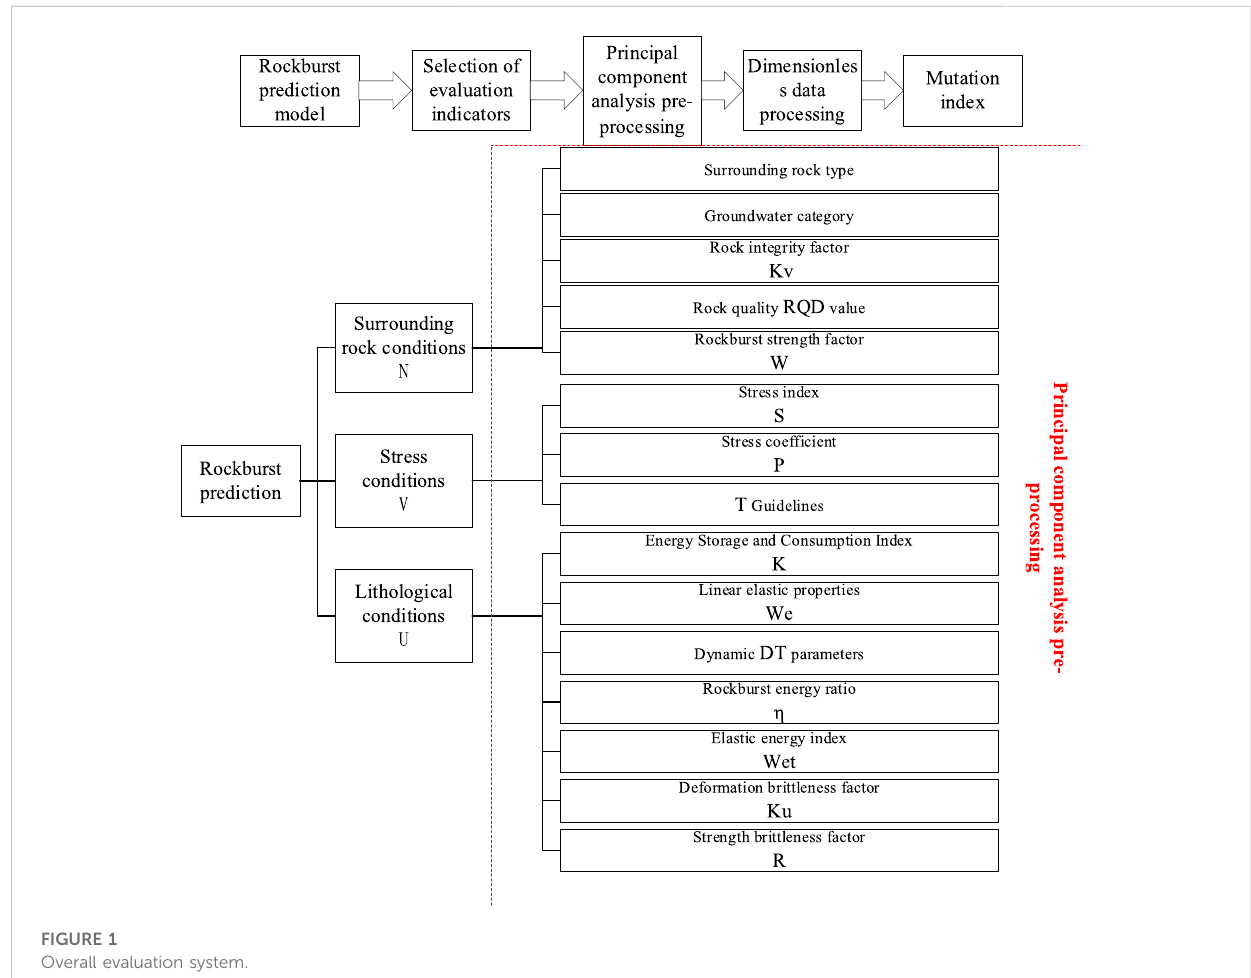
FIGURE 1 Overall evaluation